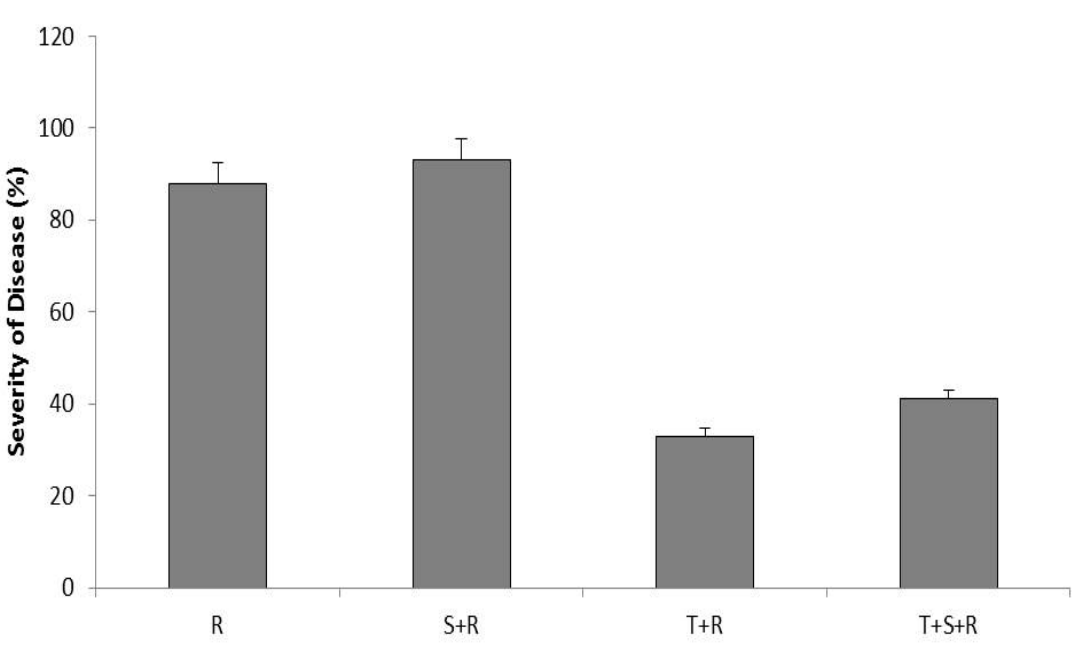
Figure 2. The effect of T. citrinoviride on severity of disease in strawberry plants which were subjected to abiotic stress (40 mM NaCl) and biotic stress ( R. solani ) either separately or in combination. Different letters indicates significant differences between treatments ( p < 0.05). R, R. solani infected; S + R, NaCl + R. solani ; T + R, T. citrinoviride + R. solani ; T + S + R, T. citrinoviride +NaCl + R. solani .